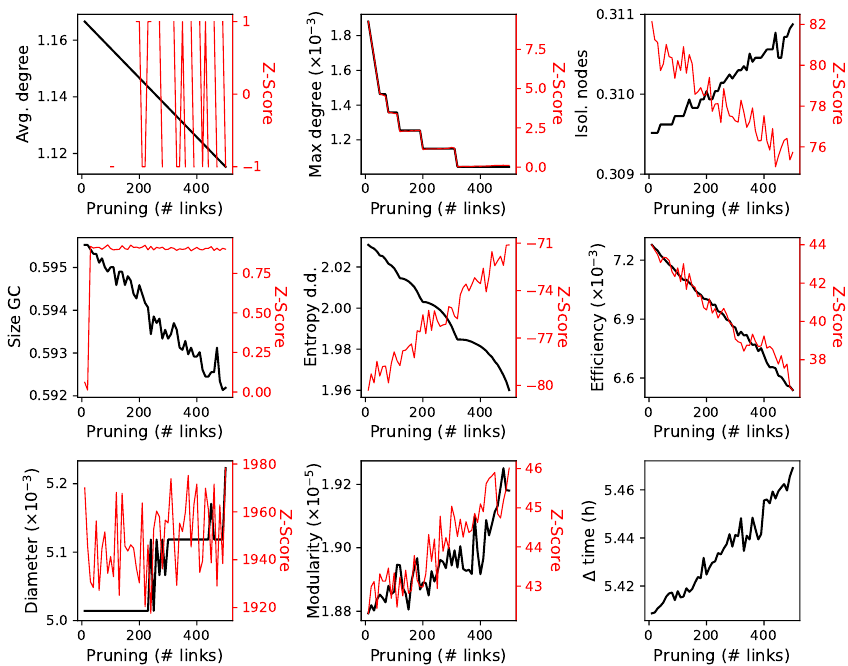
Figure A11. Properties of the interaction network for executed trajectories of 1 September, subject to a pruning process. Metrics are reported as a function of the number of deleted links—see the main text for details on the pruning algorithm. Black (left Y axes) and red lines (right Y axes), respectively, correspond to the raw values and their Z-Scores.